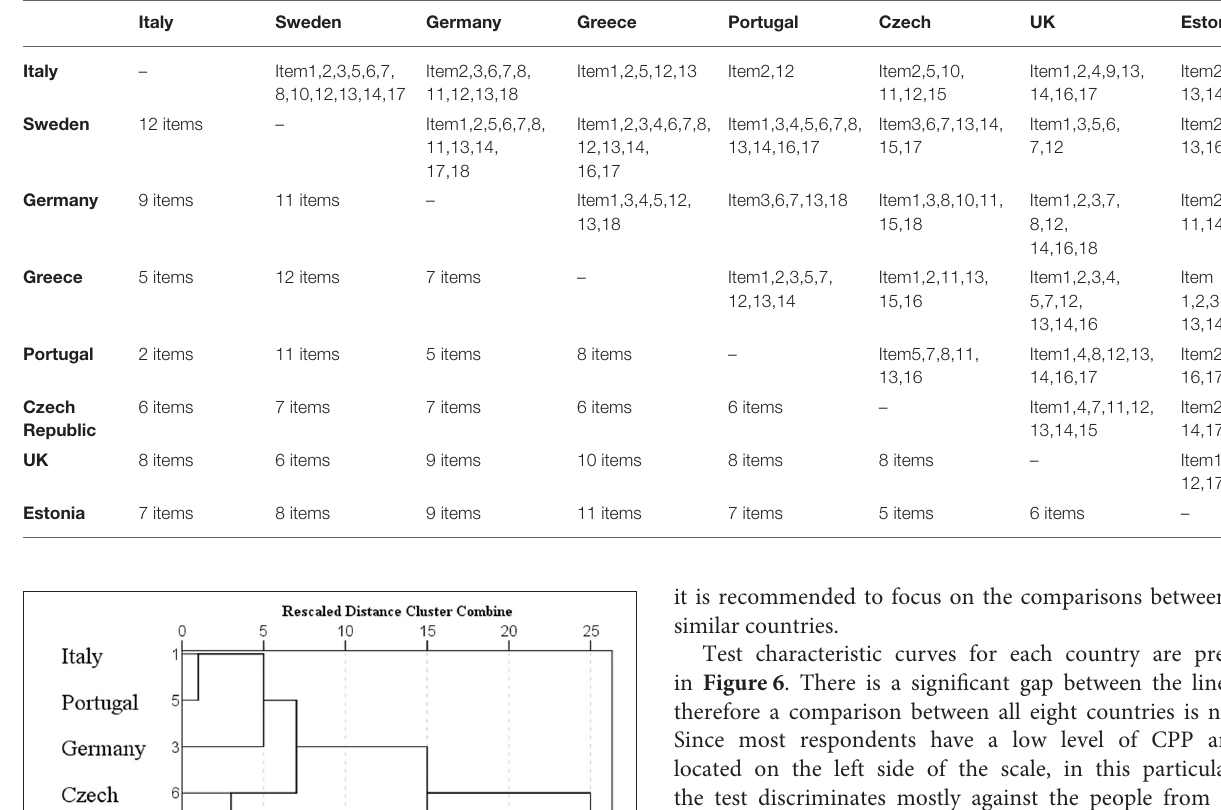
TABLE 10 | DIF type C items between countries and their total number.